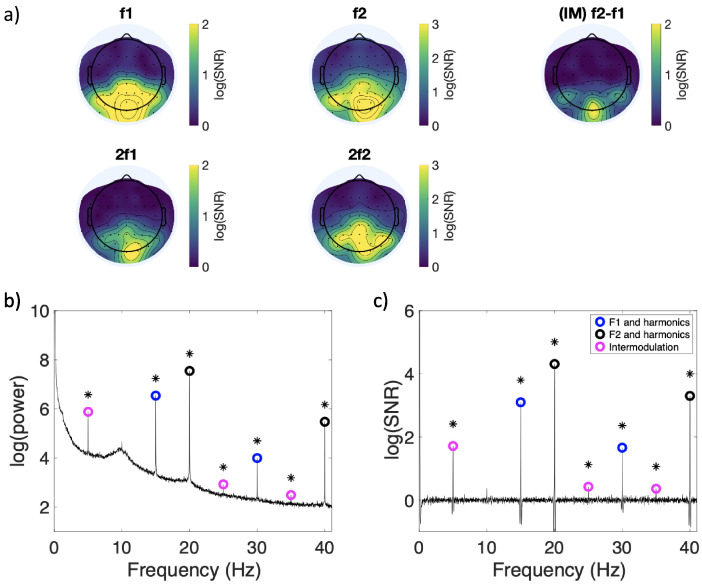
Whole trial SSVEP results.(a) The topographic distribution of SNR across participants is shown at target (f1: 15 Hz), surround (f2: 20 Hz), intermodulation (f2-f1: 5 Hz), and higher harmonic (2f1: 30 Hz, 2f2: 40 Hz) frequencies. (b) Average SSVEP responses and (c) log(SNR) for all experimental periods in our paradigm (60 s whole-trials at channel POz). Target flicker and harmonics are shown in blue, surround flicker and harmonics are shown in black, with intermodulation components shown in magenta (2f2-f1: 25 Hz and f1+f2:35 Hz are not significant, thus not shown in panel a). In (b and c), asterisks mark log(SNR) significantly different from 0 in spectrum at POz, FDR-adjusted across all frequencies to p<0.05.
Figure 2—figure supplement 2—source data 1.Whole trial power and SNR per participant.